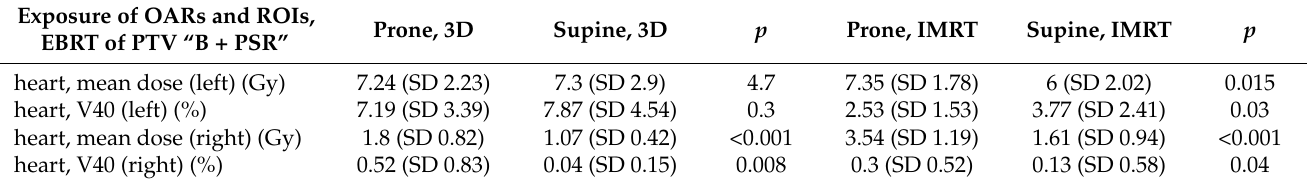
Table 3. Exposure of the OARs and ROIs, subdivided according to positioning and planning technique in Gy (mean dose) or percent (V20/V40). Here, only EBRT of PTV “B + PSR” was considered. SD: standard